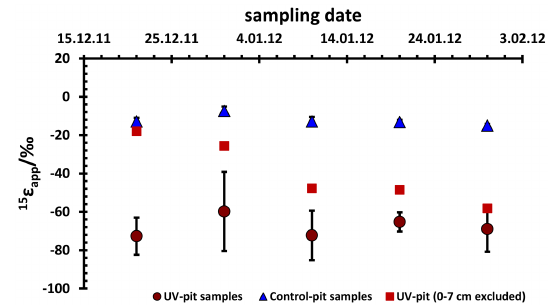
Figure 10. 15 ε values determined for the control samples (tri- angles), UV samples excluding all samples between 0 and 7cm (dashed line) and the UV samples obtained using the δ 15 N signal to identify data points affected by non-photolytic processes (cir- cles) rather than by excluding all 0–7cm data. Note that excluding the entire top 7cm data introduced an apparent trend where 15 ε app decreases with time. Errors are determined by the least square fit method as in Frey et al.